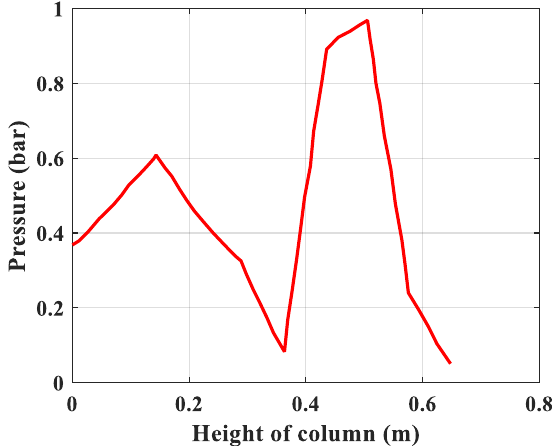
Figure 5. The result of partial pressure (O 2 ) following height of column at 5 bar.